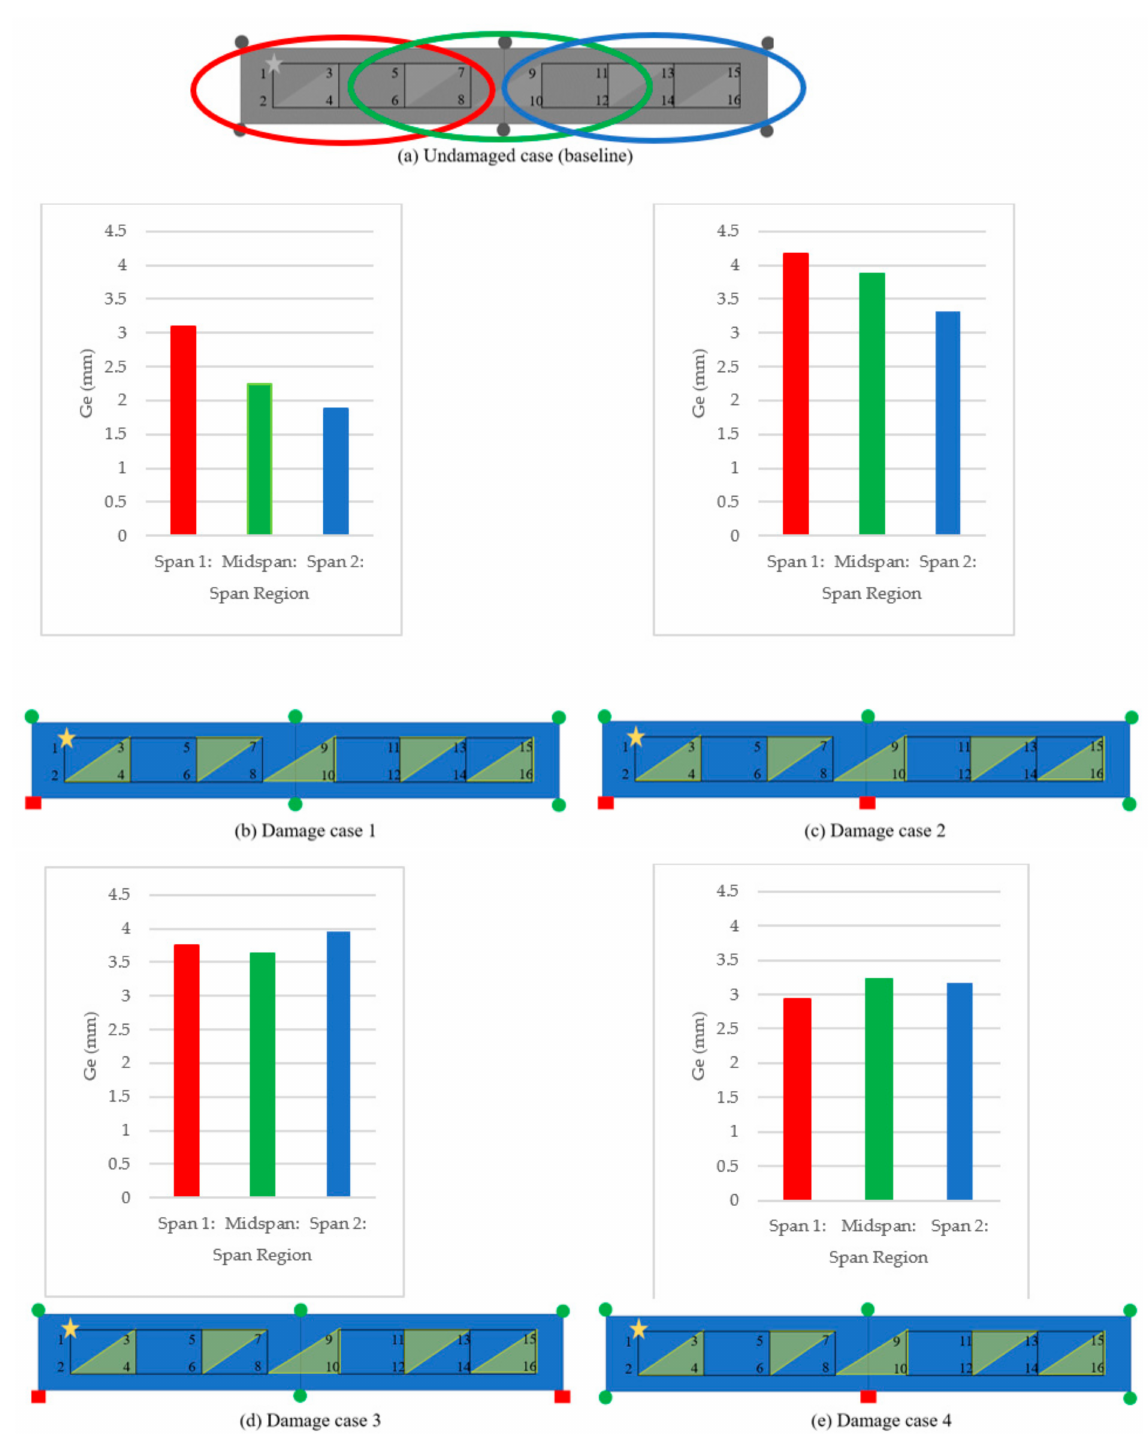
Figure 9. Group damage feature ( Ge ) for the span regions (bars) at each damage case. It is also possible to check the progression of the damage by setting one of the damage cases as the baseline response. The most logical combinations are to set (a) Damage Case 1 as the baseline and analyse Damage Case 2 and 3, and (b) Damage Case 4 as the baseline and analyse Damage Case 3 (see Figure 10) Results show that the best indications of damage locations are for Damage Case 2 (Figure 10c) and Damage Case 3 (Figure